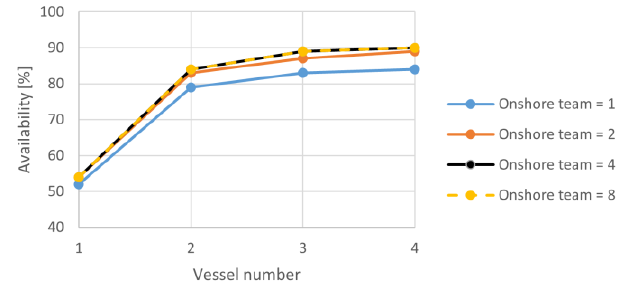
Fig. 19. Farm availability versus vessel number for various numbers of onshore teams, in the case of c/d time=2 hr and assembly team=3.